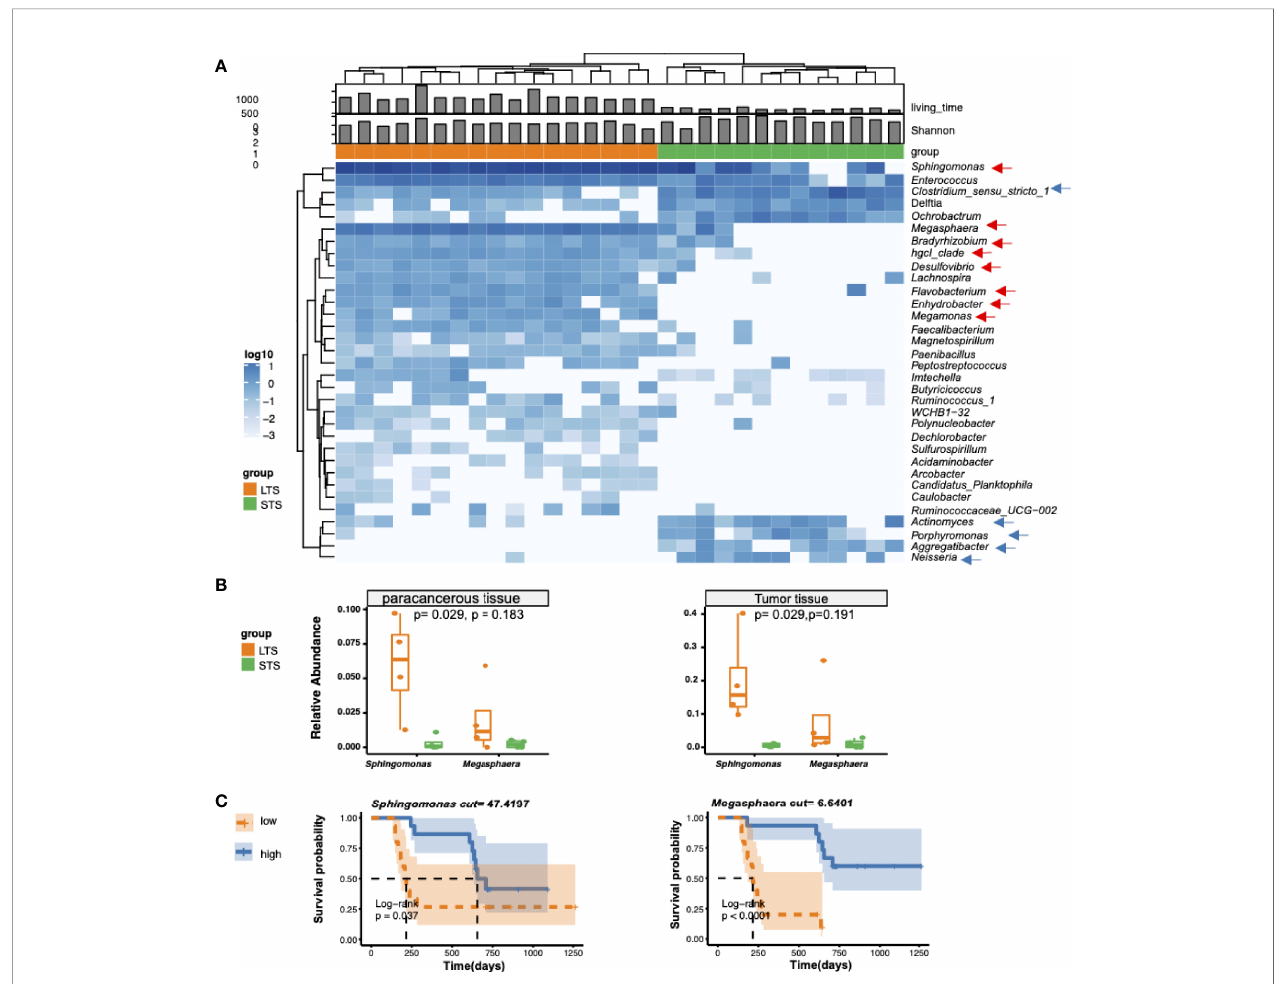
FIGURE 2 | Differential genera and survival analysis. (A) Heatmap of differentially bacterial abundant features at the genus level. Blue color represents the highest abundance, lighter blue color represents intermediate abundance, and white color represents lower abundance. Three taxa enriched in LTS samples, and 4 taxa enriched in STS samples (p<=0.001 and |R 2 |>=0.7) are presented. (B) Validation of the presence of Sphingomonas and Megasphaera in tumor tissue from LTS and STS by qPCR. 2 - DD CT method was used to calculate the relative abundance. t -test was used for statistical signi fi cance analysis. (C) Kaplan-Meier estimates for survival probability with high abundance versus low abundance of different microbiome in STS and LTS